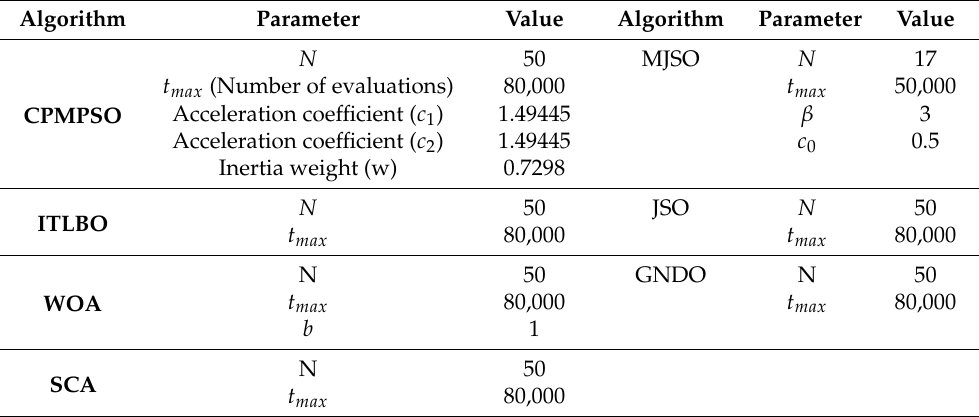
Table 5. Parameter settings of the compared